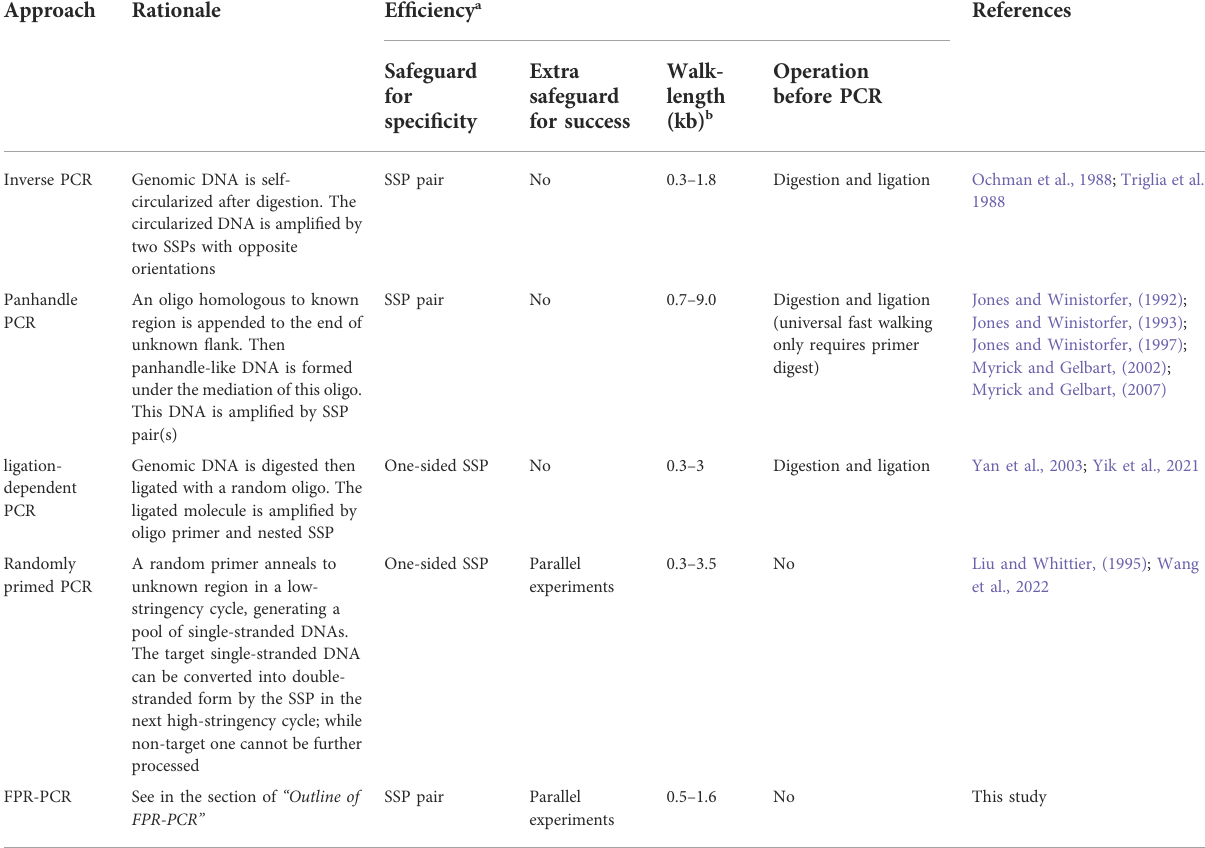
TABLE 3 Comparison of PCR-based genome-walking